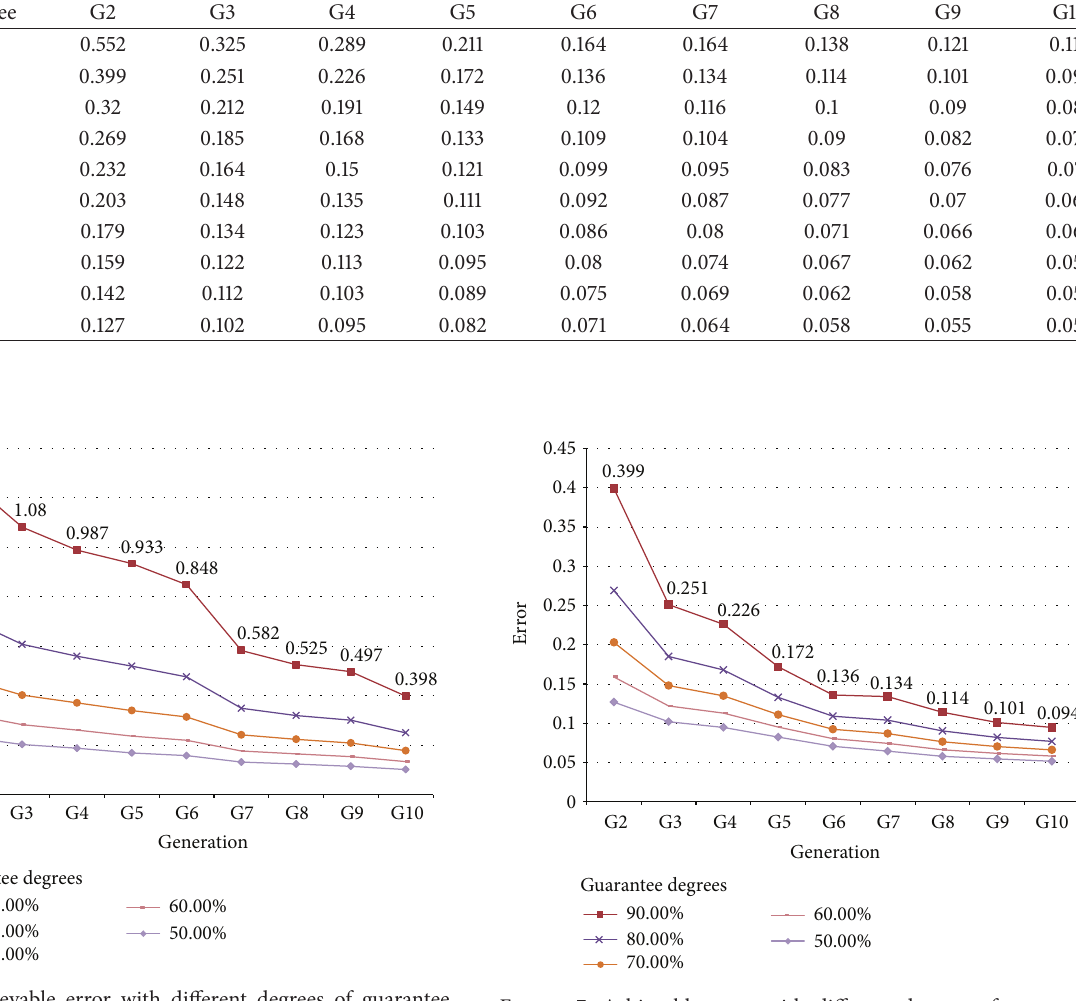
Figure 7: Achievable error with different degrees of guarantee. Populations composed of 100